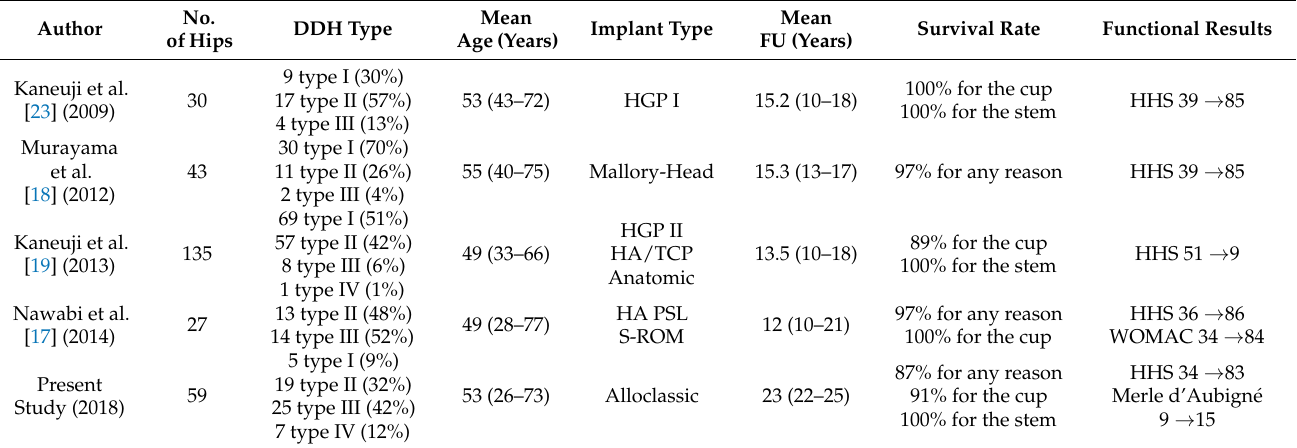
Table 1. Overview of the recent literature in the treatment of DDH with cementless